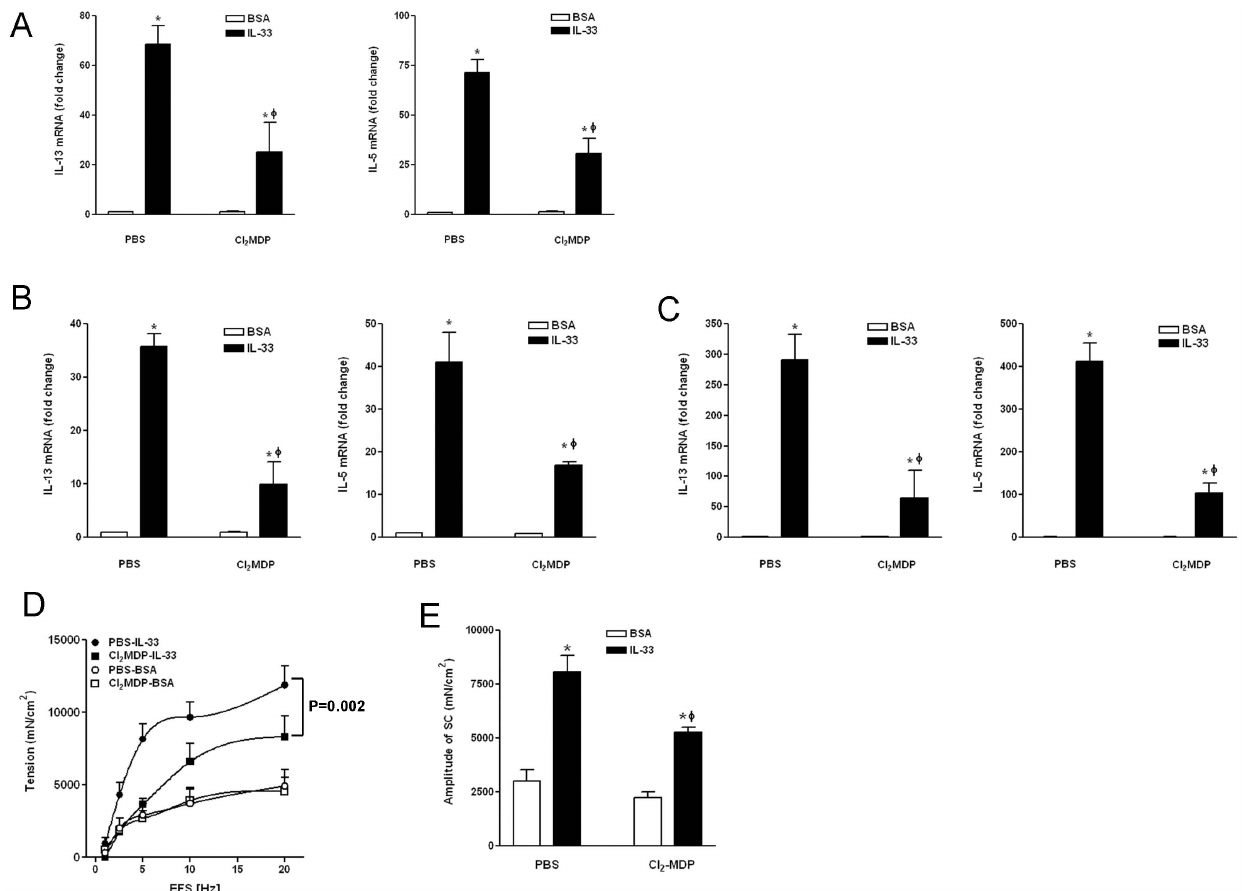
Figure 5. Macrophage depletion in mice impaired type 2 immunity induced by exogenous IL-33. A–C, IL-33-induced upregulation of IL- 13 and IL-5 was attenuated in the small intestine (A), spleen (B), and mesenteric lymph nodes (C), in mice treated with Cl 2 MDP. D, E, IL-33-induced smooth muscle hypercontractility was attenuated in mice with decreased number of macrophage as shown by the response to electric field stimulation (D, EFS) and the amplitude of spontaneous contraction (E, SC) (n=5 per group, *p , 0.05 vs respective BSA; w p , 0.05 vs PBS-IL-33, one- way ANOVA followed by Neuman-Keuls test; p=0.002 was generated from two-way ANOVA with repeated measures between the two curves). Data shown in bar and line graphs are the means 6 s.e.m, and are representative of two independent